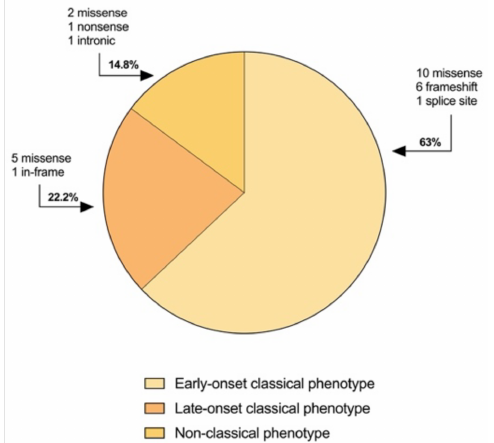
Figure 5. Distribution of the 27 SLC2A1 variants observed in our cohort according to the different phenotype.